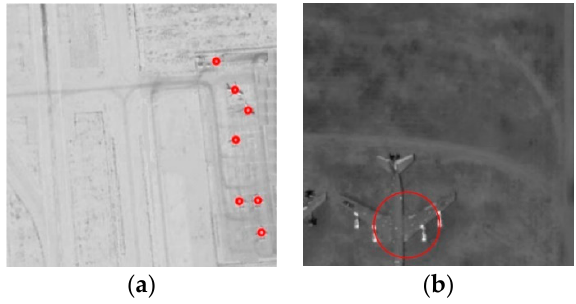
Figure 6. Clustering result graph. ( a ) Multiple small objects; ( b ) Weak object.